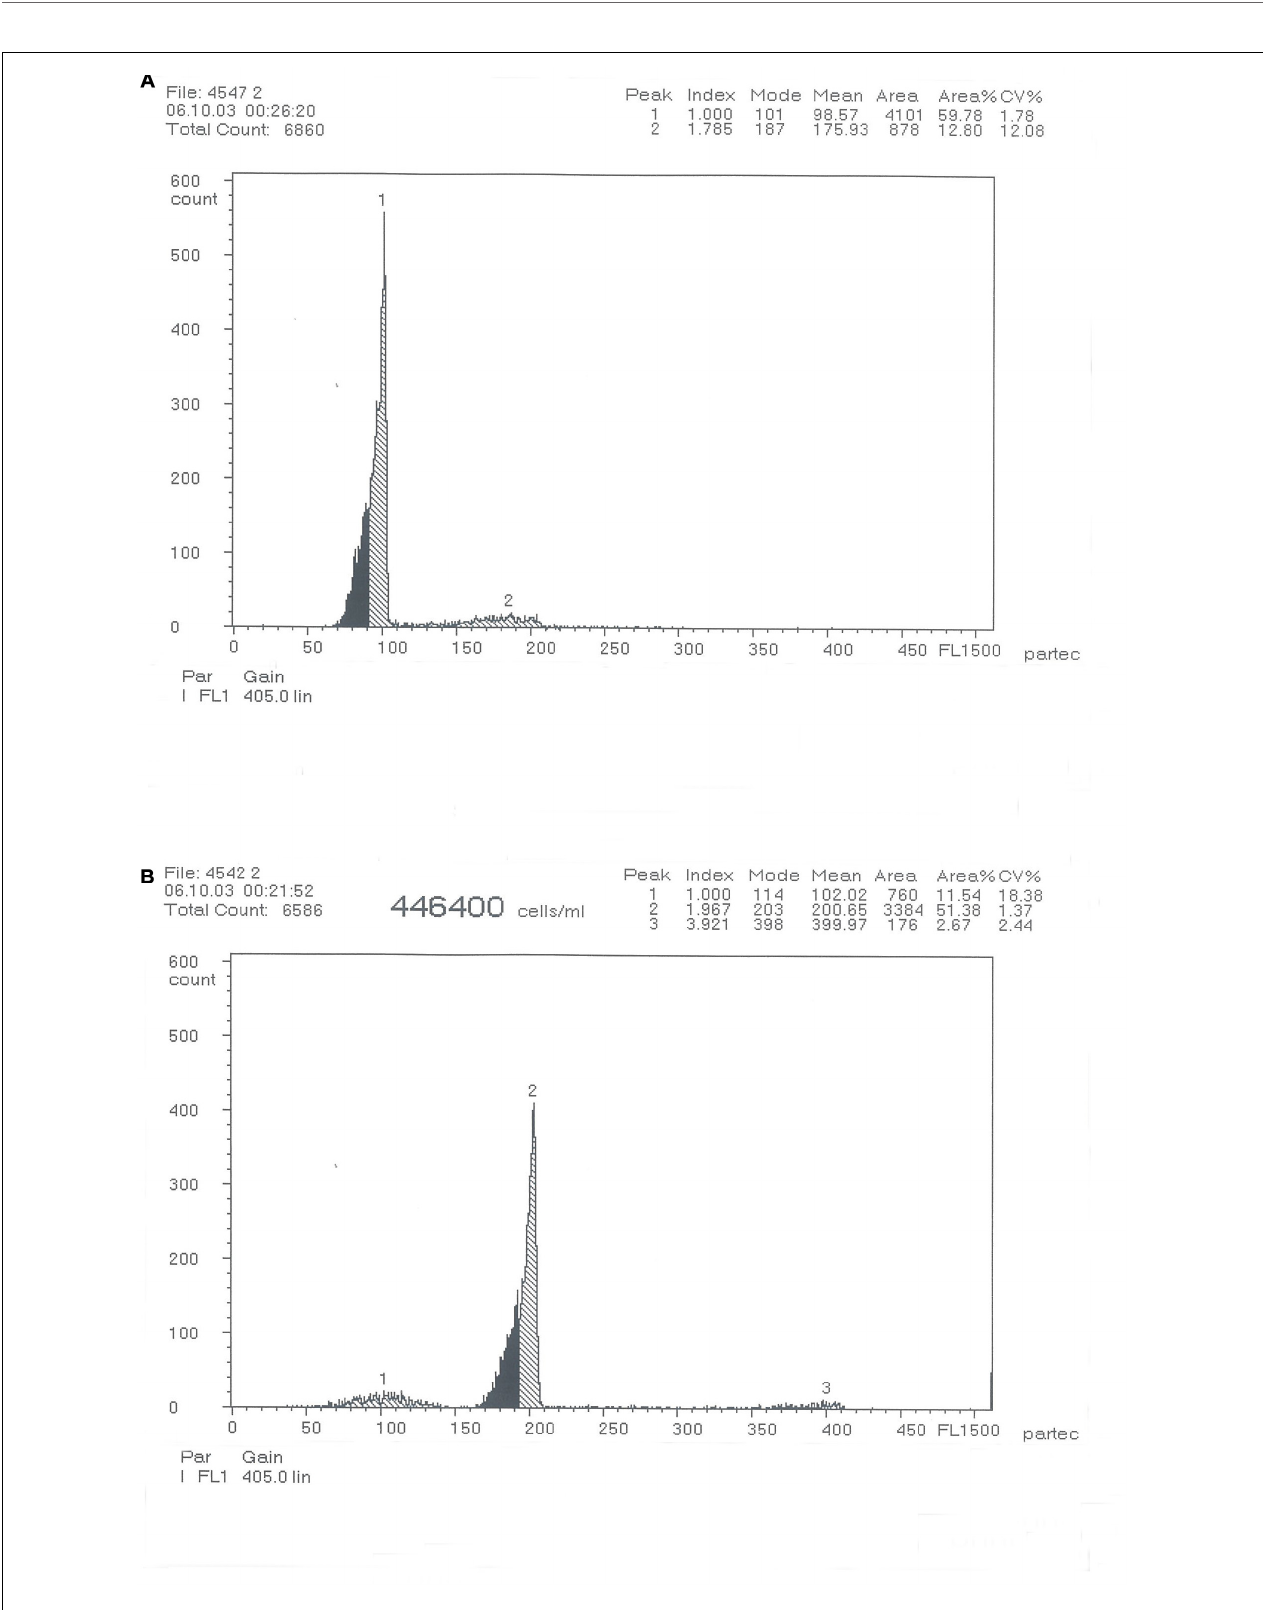
FIGURE 1 | DNA-content flow-cytometrical histograms of Carassius auratus red var. (RCC) (A) and Autotetraploid Carassius auratus (4nRR) (B) .